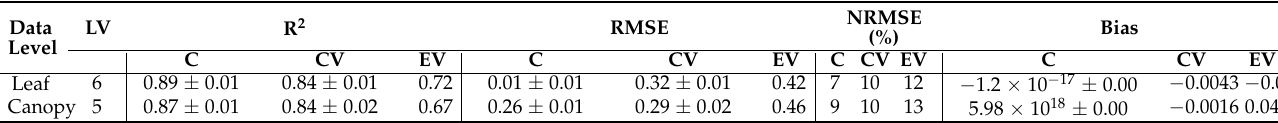
Figure 3. Observed vs. predicted values of nitrogen level estimates for 2018 collections using coefficients from the 2017 model. ( a ) Estimates generated using leaf-level spectral measurements; ( b ) estimates generated using canopy-level spectral measurements. Error bars for estimated values represent the standard deviation generated from 500 model permutations using an 80:20 calibration:cross-validation approach. Dashed line: 1:1 relationship. R 2 : model goodness of fit; RMSE: root-mean-square error; NRMSE: normalized root-mean-square error. Table 2. Multi-year models’ performance: number of latent variables (LVs), model goodness of fit ( R 2 ), root-mean-square error (RMSE), normalized root-mean-square error (NRMSE), and bias for calibration (C), cross-validation (CV), and external validation (EV). Data generated via cross-validation using 500 random permutations of the dataset with 70% of the total data divided into 80:20 split for C and CV, respectively, for models predicting nitrogen concentrations from wheat foliage using hyperspectral data. EV was generated by applying coefficients generated from the C:CV approach to the 30% of the data excluded from the C:CV approach. Data shown as mean ± standard